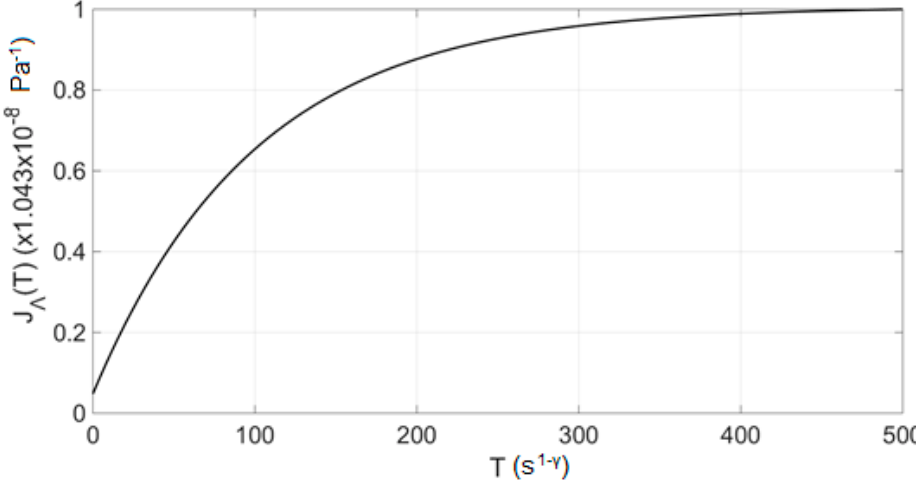
Figure 7. Variation of the creep compliance versus time in Λ -Space.